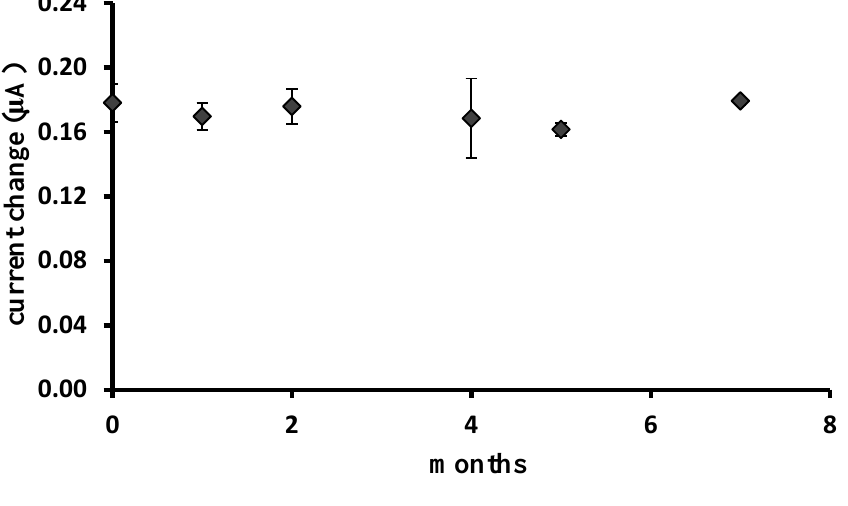
Figure 7. The effect of storage time on the stability of the capsaicin biosensor response measured at 99.0 µM capsaicin (100 µM H